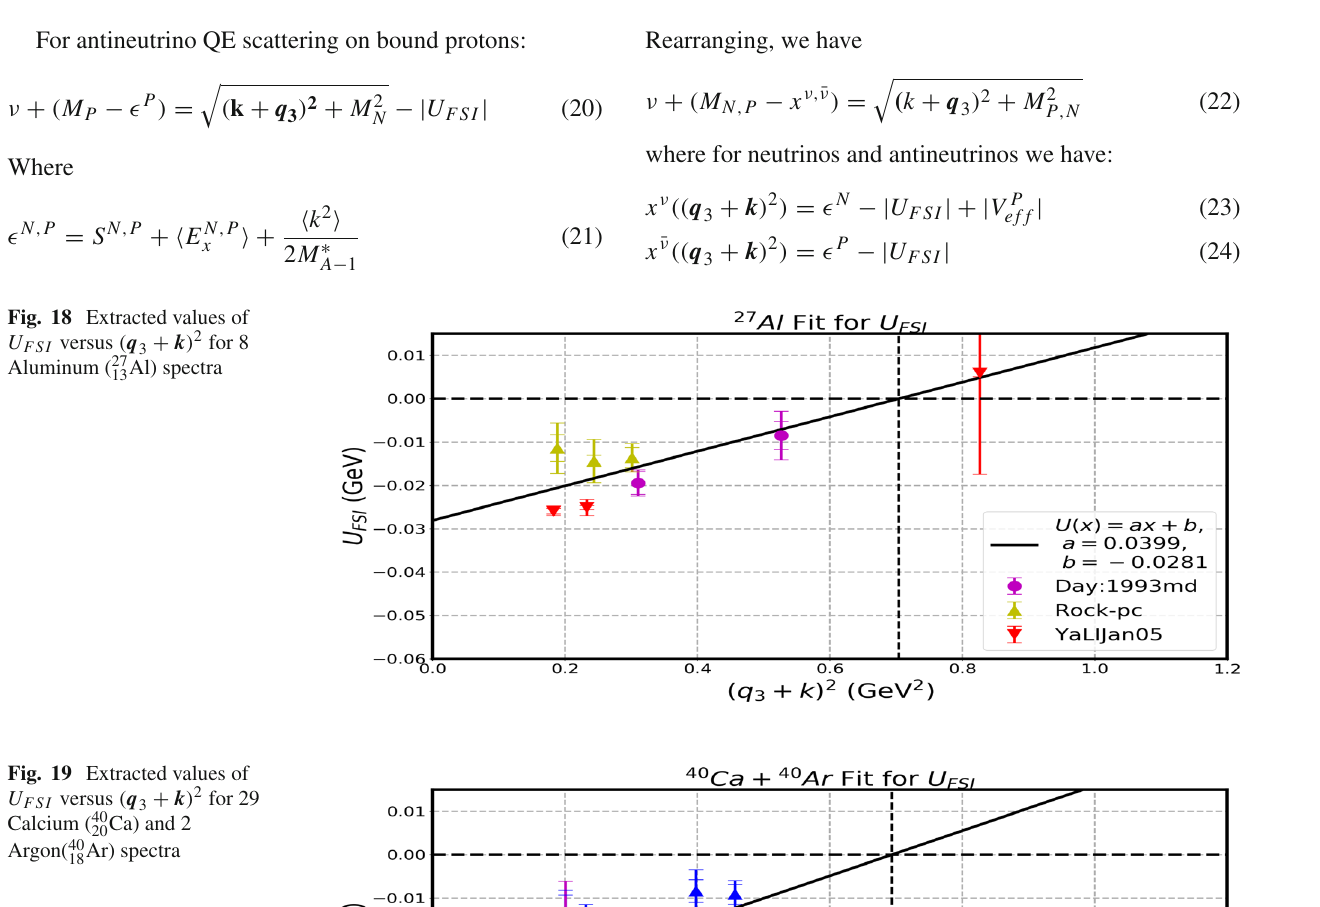
Fig. 19 Extracted values of U FSI versus ( q 3 + k ) 2 for 29 Calcium ( 40 Ca) and 2 20 Argon( 40 Ar) 18